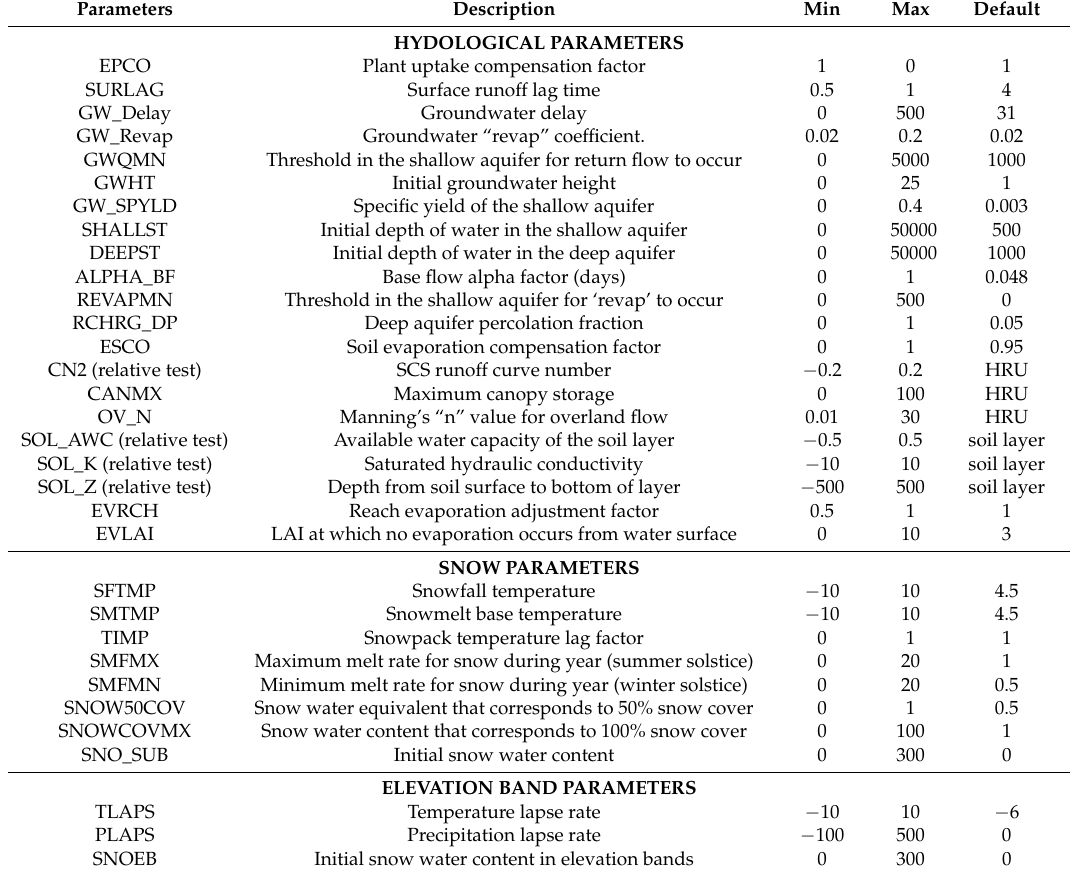
Table 4. Parameters considered for the sensitivity